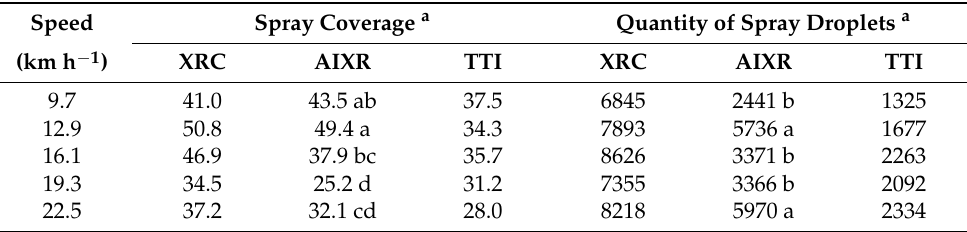
Table 5. Influence of ground speed on spray coverage (%) and quantity of spray droplets by nozzle type for SRC. SRC represents the sprayer equipped with a rate controller used in this